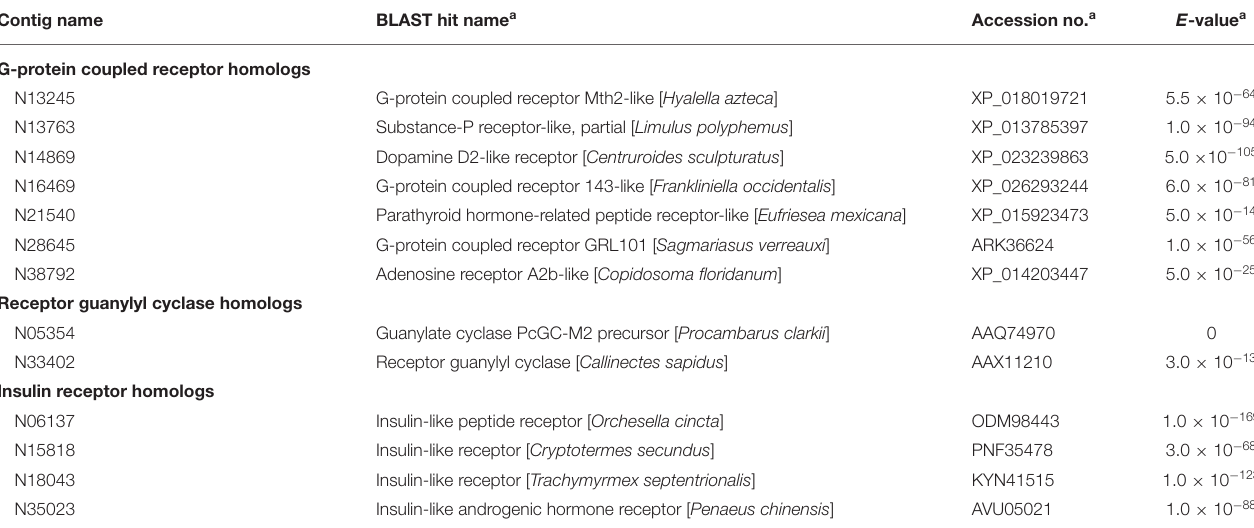
TABLE 1 | Putative hormone receptors found in the ovarian transcriptome.